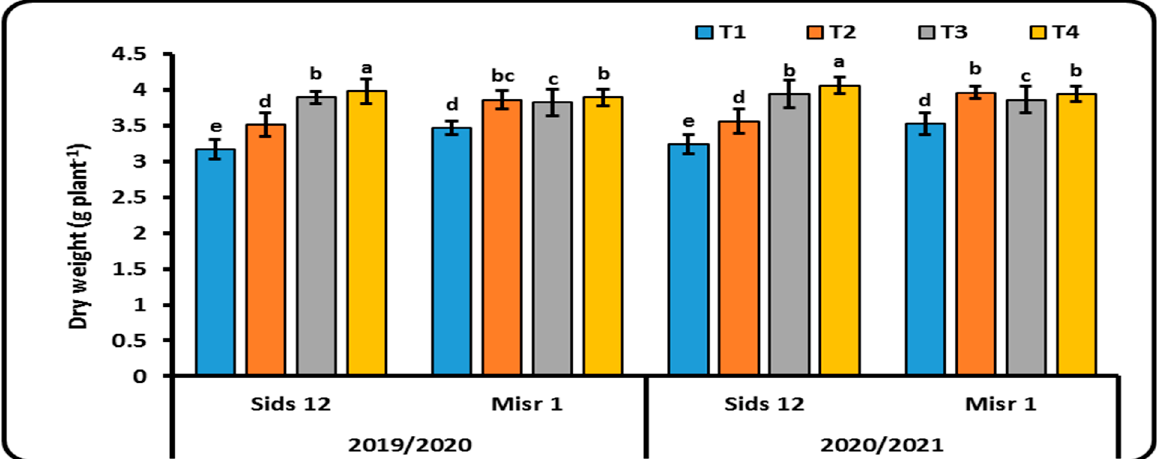
Figure 1. Impact of different treatments (EM, CT, and combination) on some vegetative growth parameters 70 days after sowing during the two growing seasons. Duncan’s test ( p ≤ 0.05); means for the same growing season denoted with different letters indicate significant differences across treatments. ( ± ) means standard deviations (SD, n = 3). Control (T1); EM (T2); CT (T3); EM + CT (T4).